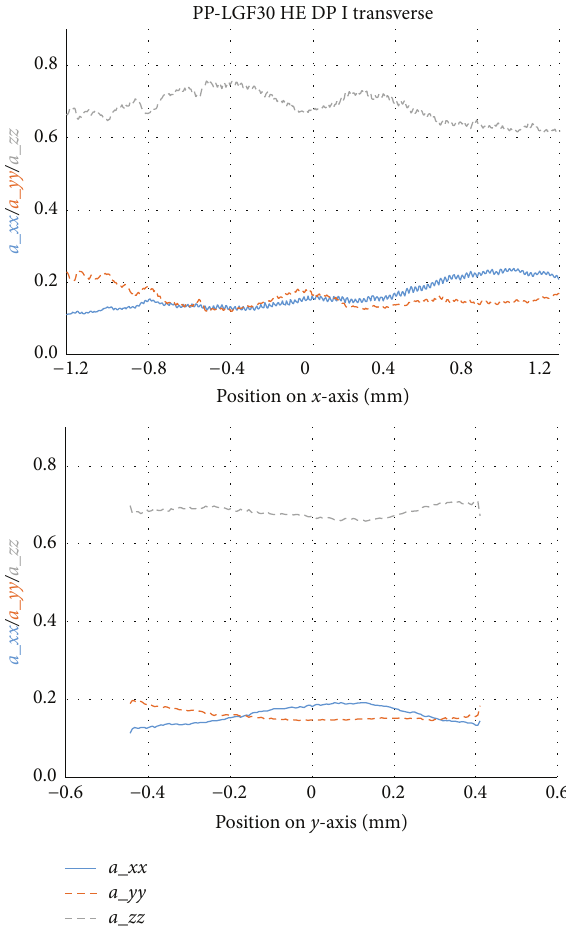
Figure19:Progressofthefiberorientationalongthe 𝑥 -and 𝑦 -axisin the weld of two plates in hot plate welding of PP-LGF30 with initial fiber orientation being transverse to the joining